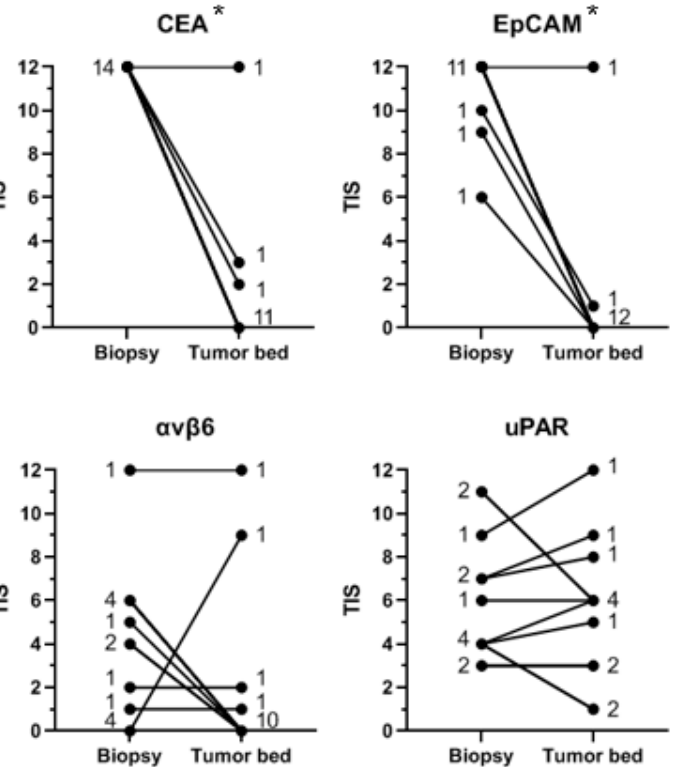
Figure 4. Target expression in tumor tissue in the diagnostic biopsy compared to the pCR tumor bed in the corresponding resection specimen. Notes: Shown is the target expression (as TIS) in the diagnostic biopsy compared to the pCR tumor bed in the corresponding resection specimen, per patient and per target. Every line represents one or more patients. The number of patients with a certain expression score (TIS) in the biopsy and tumor bed is indicated next to the corresponding lines. A horizontal line indicates the same level of expression between biopsy and tumor bed. A descending or ascending line indicates respectively a higher or lower expression in the biopsy compared with the tumor bed. The asterisks (*) indicate a significantly higher expression in the diagnostic biopsy compared with the corresponding pCR tumor bed in the resection specimen. Abbreviations: TIS, total immunostaining score; CEA, carcinoembryonic antigen; EpCAM, epithelial cell adhesion molecule; α v β 6, integrin α v β 6; uPAR, urokinase-type plasminogen activator receptor; pCR, pathological complete